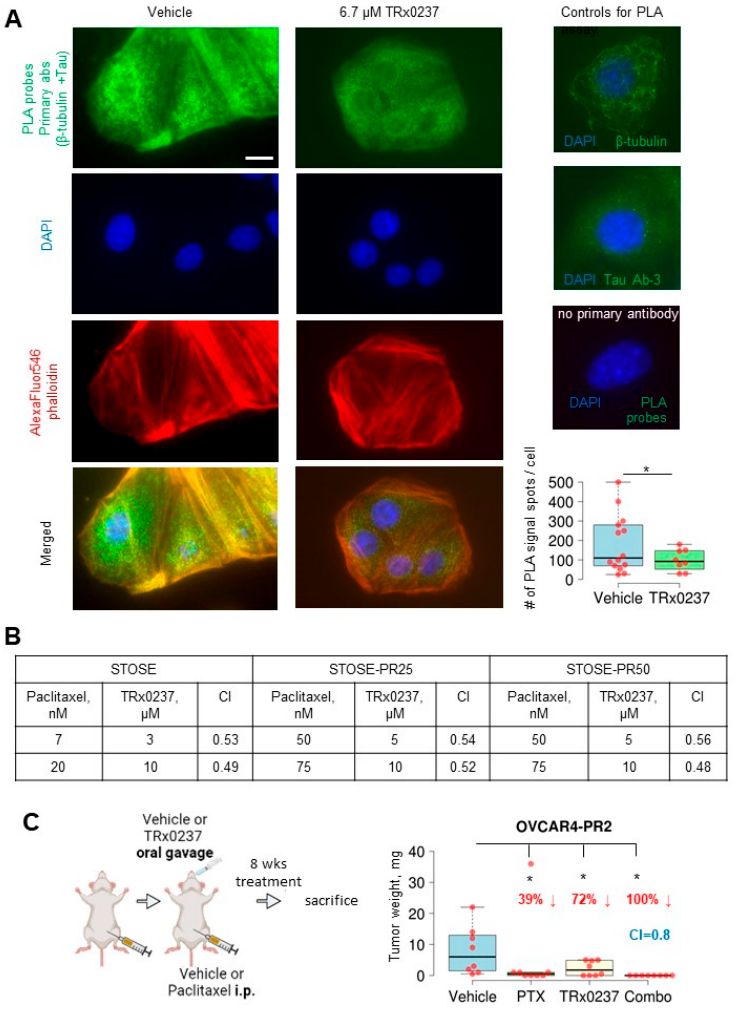
Figure 5. TRx0237 reduces tau bound to microtubules and synergizes with paclitaxel in eliminating tumor burden in the paclitaxel ‐ resistant OVCAR4 ‐ PR2 xenograft model. ( A ) OVCAR ‐ 4 were treated, or not, with 6.7 μ M TRx0237 for 24 h and subjected to proximity ligation assay (PLA) using tau Ab ‐ 3, β‐ tubulin antibodies, and green fluorescence PLA probes. The actin cytoskeleton and nu ‐ clear DNA were stained with AlexaFluor546 phalloidin and DAPI. Bar, 5 micron. Images were ac ‐ quired using Zeiss fluorescence microscope. Images were superimposed using Zeiss Axiovert soft ‐ ware. Green fluorescence signal generated due to PLA probes when both tau and β‐ tubulin anti ‐ bodies are 0–40 nm was quantified as spots/cell in 10 randomly selected cells in three independent experiments, averaged, plotted as box graphs using The BoxPlotR software, and statistically ana ‐ lyzed with Mann–Whitney U test. * p < 0.05. Immunostaining with tau Ab ‐ 3 and β‐ tubulin antibod ‐ ies (1:100 dilution) individually and with no primary antibodies used as controls. ( B ) STOSE and its paclitaxel ‐ resistant clones were treated for 24 h with indicated concentrations of paclitaxel or TRx0237, or not treated, followed by examination of 1% of treated cells in a clonogenic assay. Colo ‐ nies of ≥ 50 cells were quantified. The Combination Index (CI) was calculated based on the Chou ‐